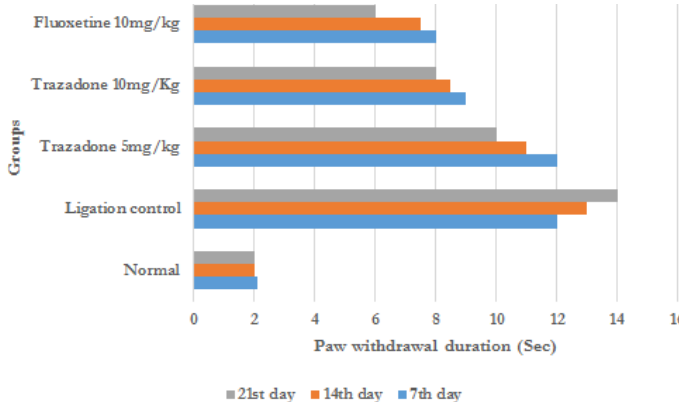
FIGURE 2 - Effect of trazodone on mechanical hyperalgesia in partial sciatic nerve ligated